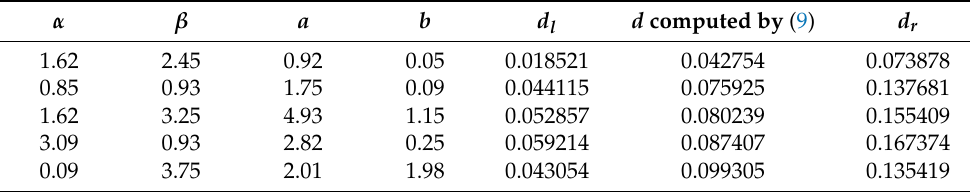
Table 2. Bounds for the one-sided Hausdorff distance d computed by Theorem 3.